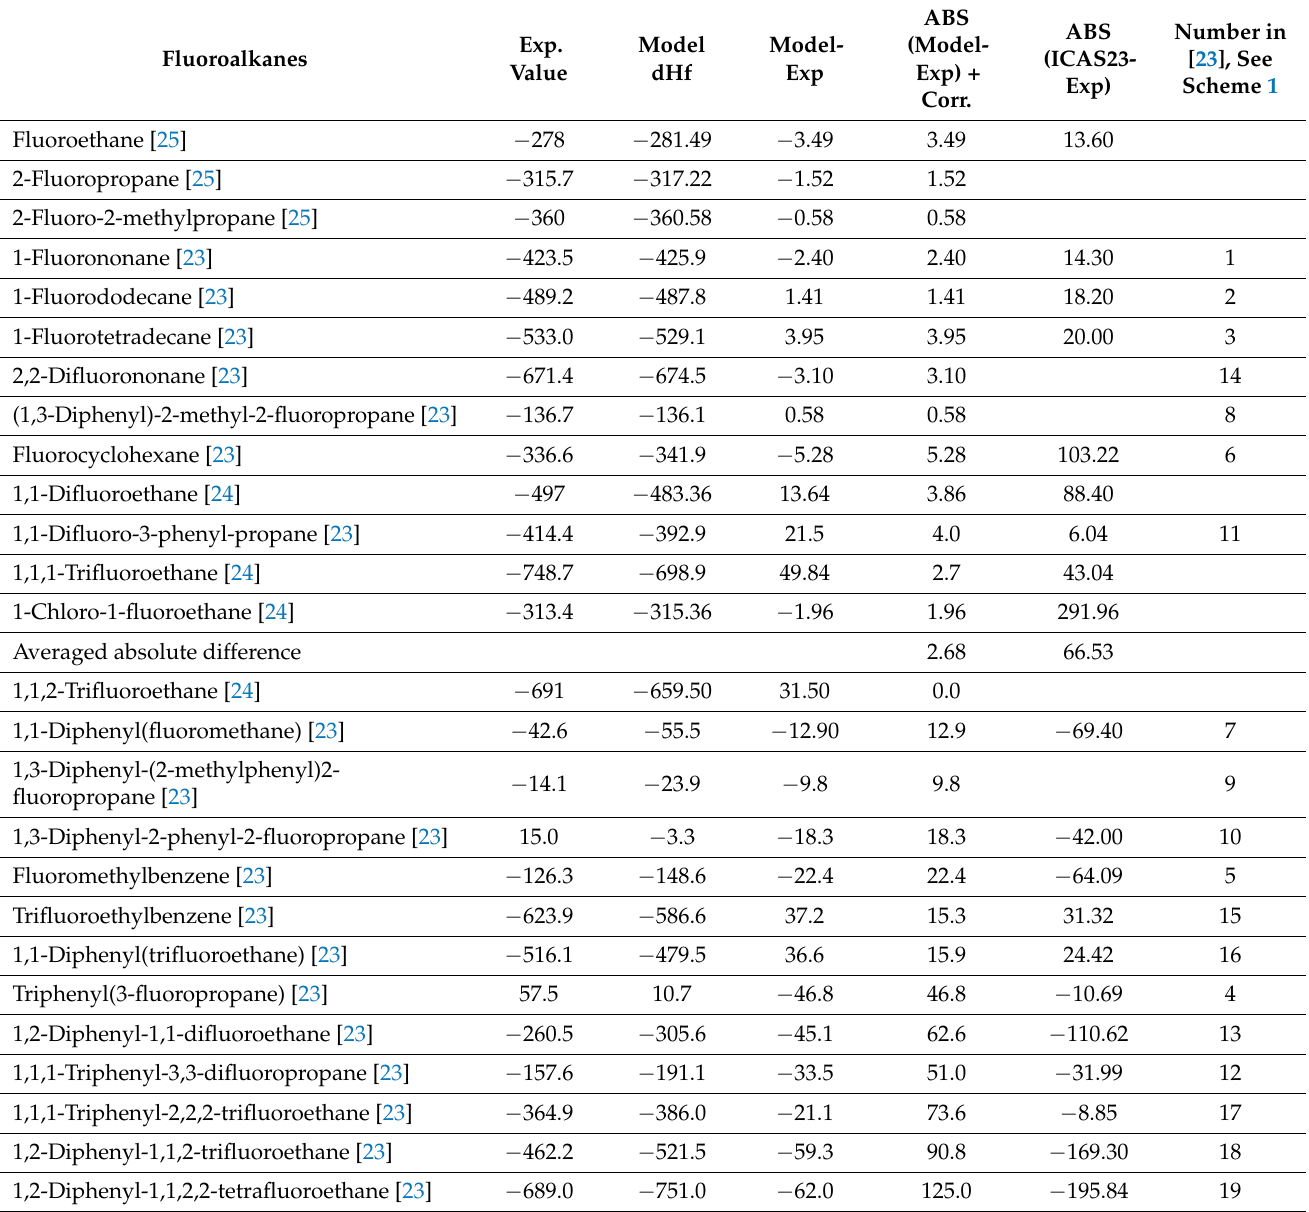
Table 4. Experimental and model values for fluoroalkanes. All values in kJ/mol. Most experimental values were taken from [23] and some more from [24,25]; for comments, see the text. The corrections (corr.) in column 5 only apply to species involving 1,1- or 1,2-difluoro interactions; for an explanation, see the